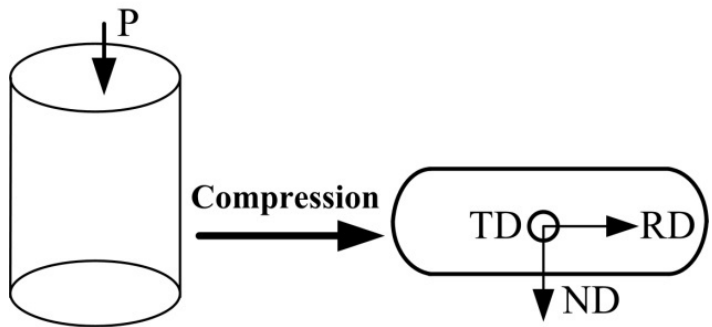
Figure 1. Compression process and the orientations of the specimen.